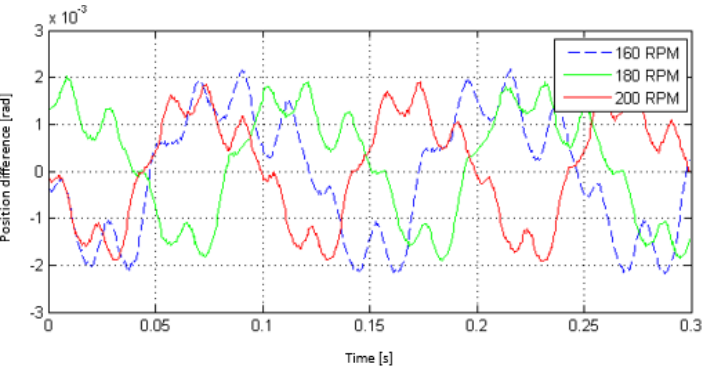
Figure 18. Courses of needle cylinder and dial position deviations after stabilization of their move- ment, for velocities of 160–200 min − 1 .